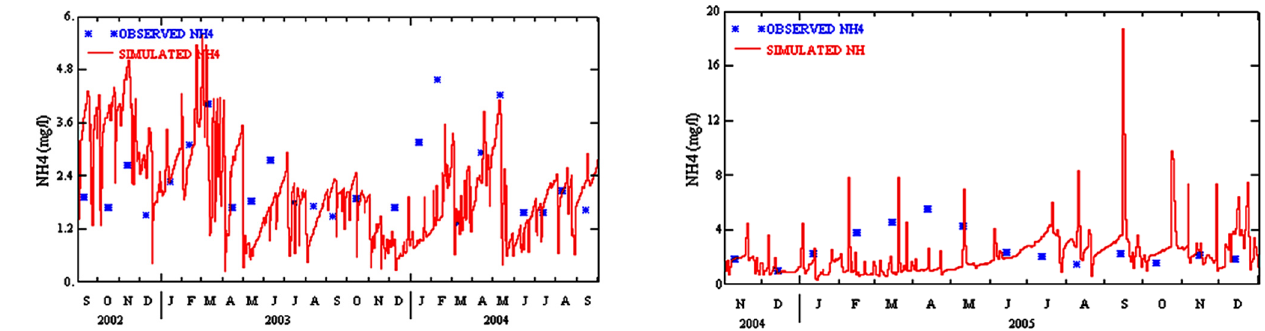
Figure 4. Total ammonium calibration and validation.